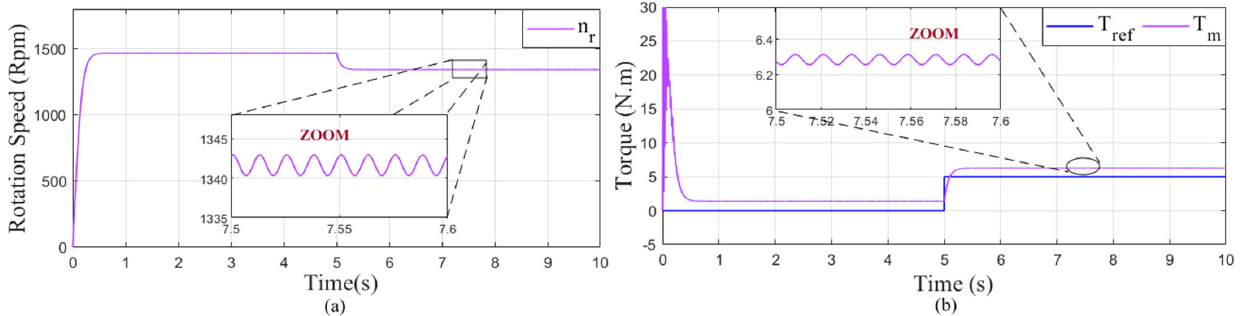
Figure 16. Performance with OR bearing defect of IM without control: ( a ) rotation speed and ( b ) motor torque.